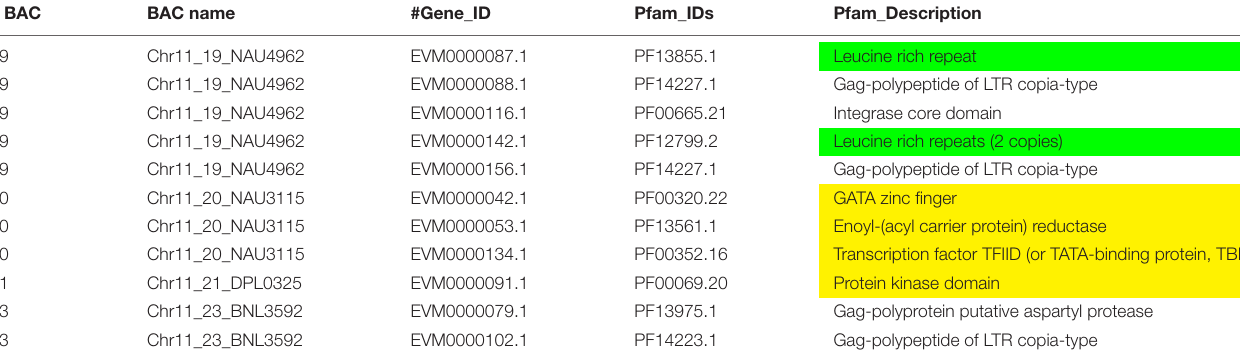
of potato virus X resistance protein and similar proteins ( Figure 3 , highlighted in light blue). Interestingly, six aa between the position 247 and 248 and 37 aa between the position 270 and 271 are always missing in the NB-ARC region (highlighted in yellow, Figure 3 ) of the gene EVM0000014.1 compared with other homologous resistance proteins ( Figure 3 and NCBI database). In addition, the seven LRR domains between aa 407 and aa 670 (highlighted in green and gray) in the gene EVM0000014.1 were found homologous with